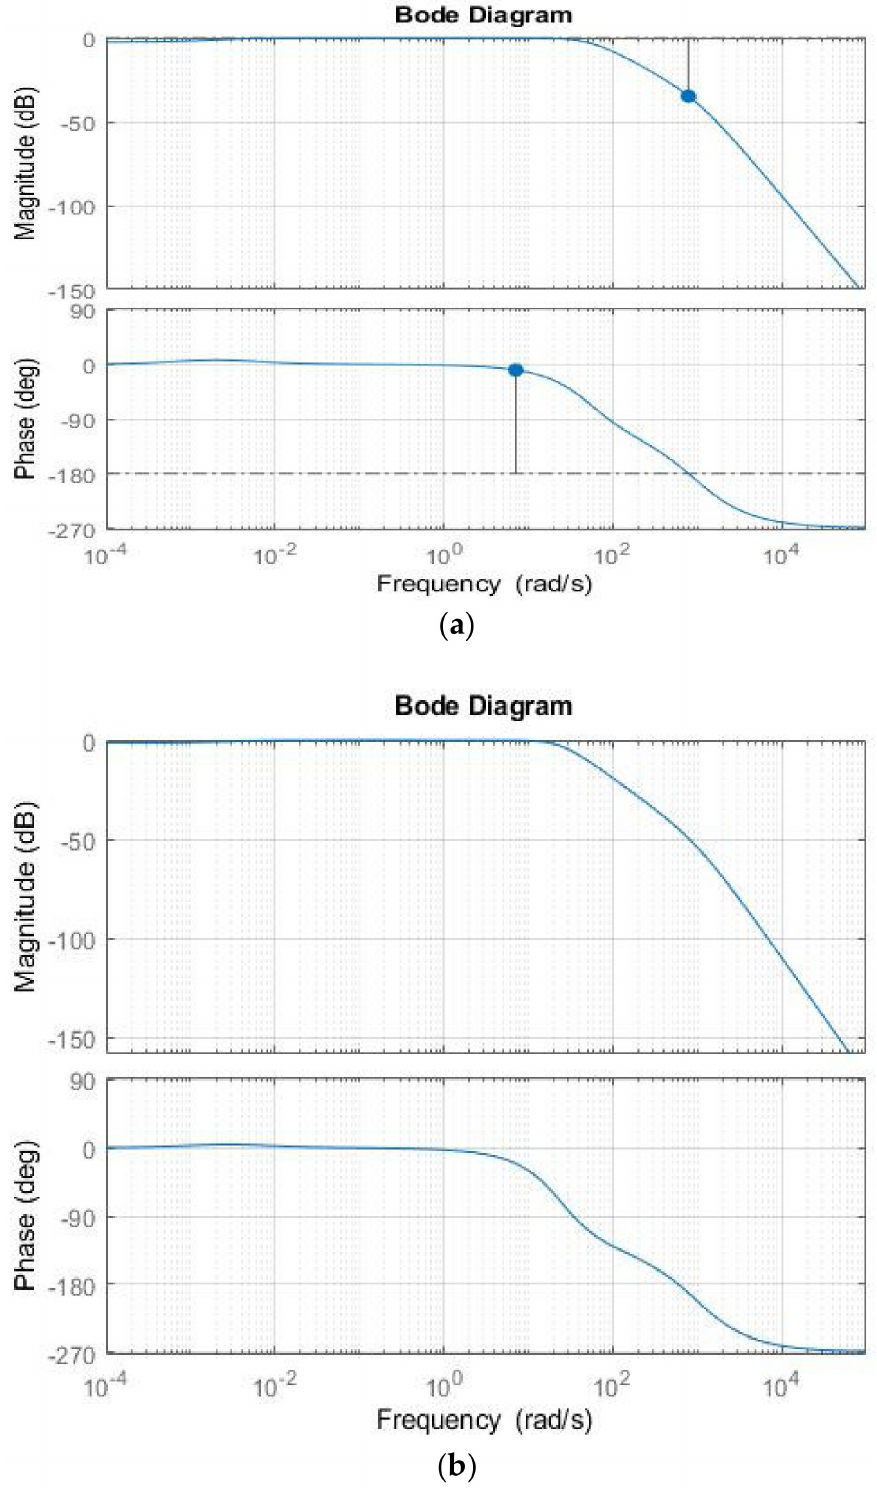
Figure 12. ( a ) Closed-loop Bode plots of LQR-FD compensator for λ = 0.6: fault-free, and ( b ) closed-loop Bode plots of LQR-FD compensator with 50% loss of actuator effectiveness for λ =